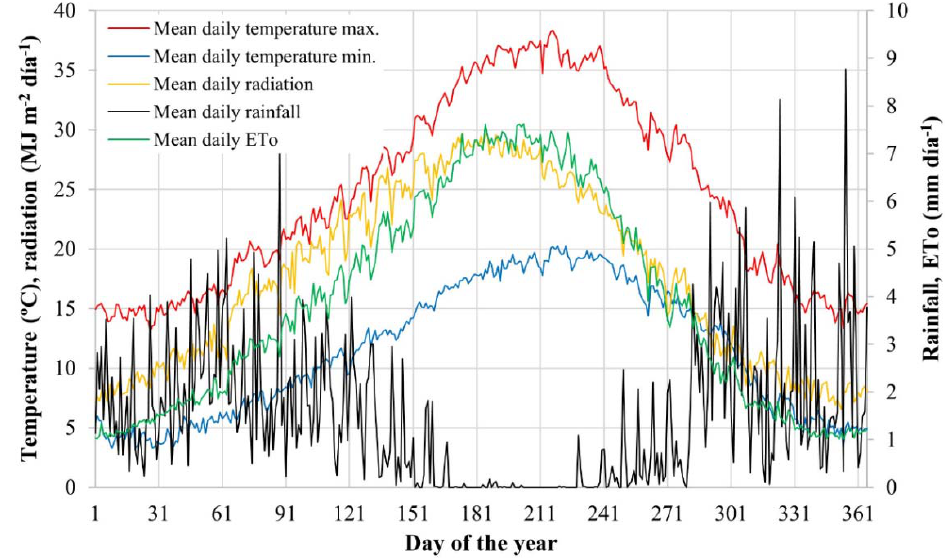
Figure 7. Average values of the evolution of the daily maximum and minimum temperature, radiation, precipitation and ET o in the study area (2004–2018).